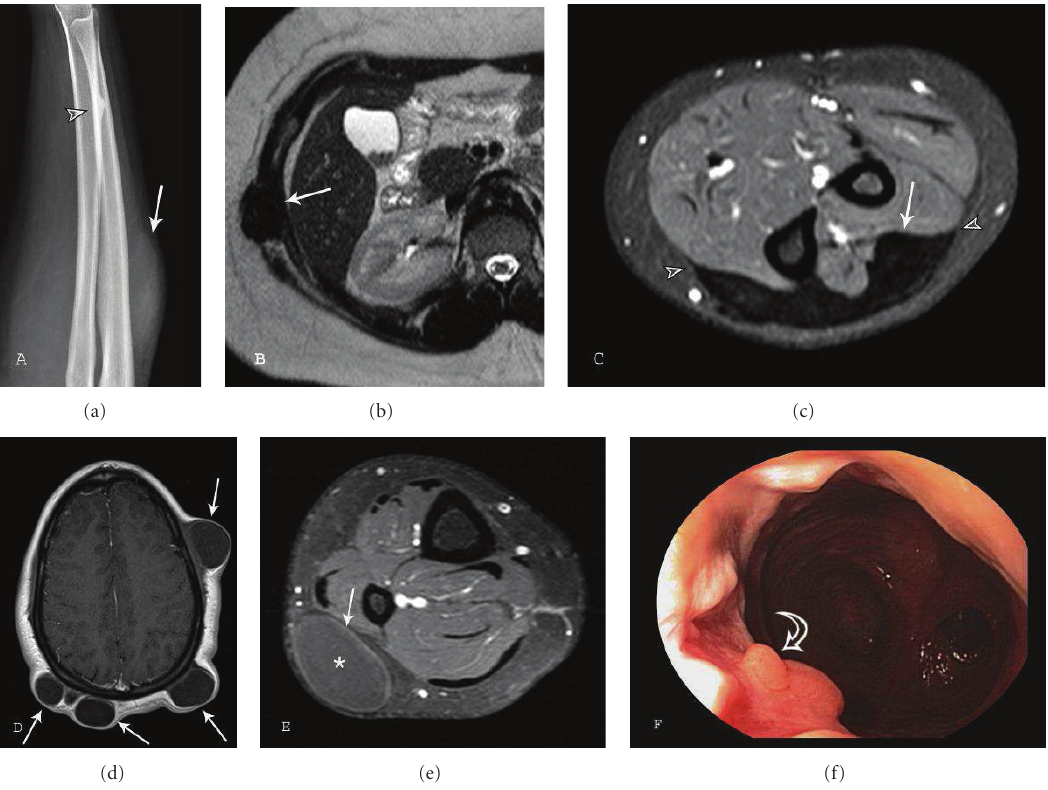
Figure 12: Imaging of gardner syndrome: a teenage female with Gardner syndrome. Images were obtained from age 13 to 16 years-of-age. (a) Lateral radiograph of the forearm demonstrates an osteoma (arrowhead) of the distal radial diaphysis. Also note the soft tissue mass (arrow) corresponding to extraabdominal desmoid imaged with MR in 11c. (b) Axial T2 (TR544.326/TE100) sequence through the upper abdomen demonstrates fibromatosis (arrow) involving the left intercostal muscles. (c) Axial T1 (TR539.09/TE15) fat saturation postcontrast of the upper forearm reveals a mature (collagenized) extraabdominal fibromatosis (arrow) along the dorsal superficial fascia with no significant enhancement. Note the fascial tail sign (arrowheads). (d) Axial T1 (TR491/TE11) postcontrast of the scalp and (e) axial T1 (TR667/TE10) fat suppression postcontrast of the calf reveal multiple epidermal inclusion cysts (arrows) of the subcutaneous tissues with mild peripheral enhancement. Follow-up endoscopy (f) of the patient status post colectomy for multiple tubular adenomas demonstrates development of an adenomatous polyp within the distal